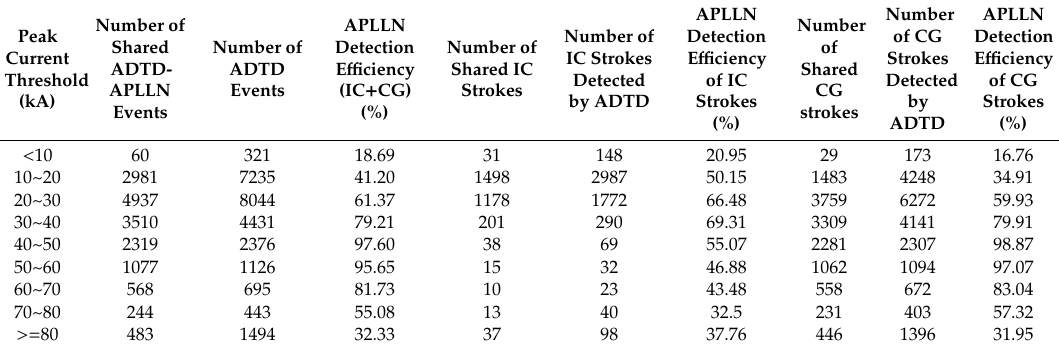
Table 2. The stroke detection e ffi ciency of the APLLN relative to the ADTD under di ff erent peak current